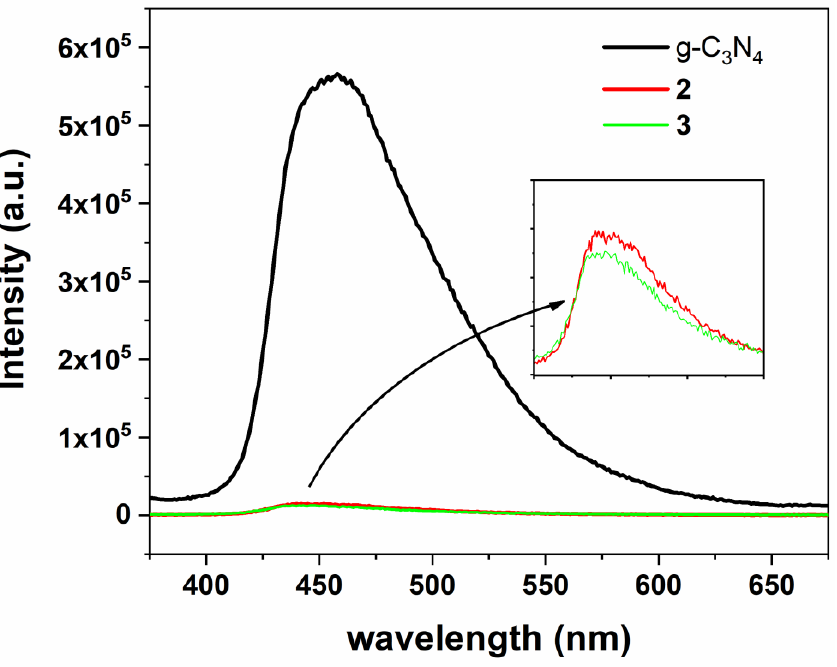
Figure 9. Photoluminescent spectra of g-C 3 N 4 and nanohybrids 2 and 3 in solid state (excitation wavelength is 350 nm).